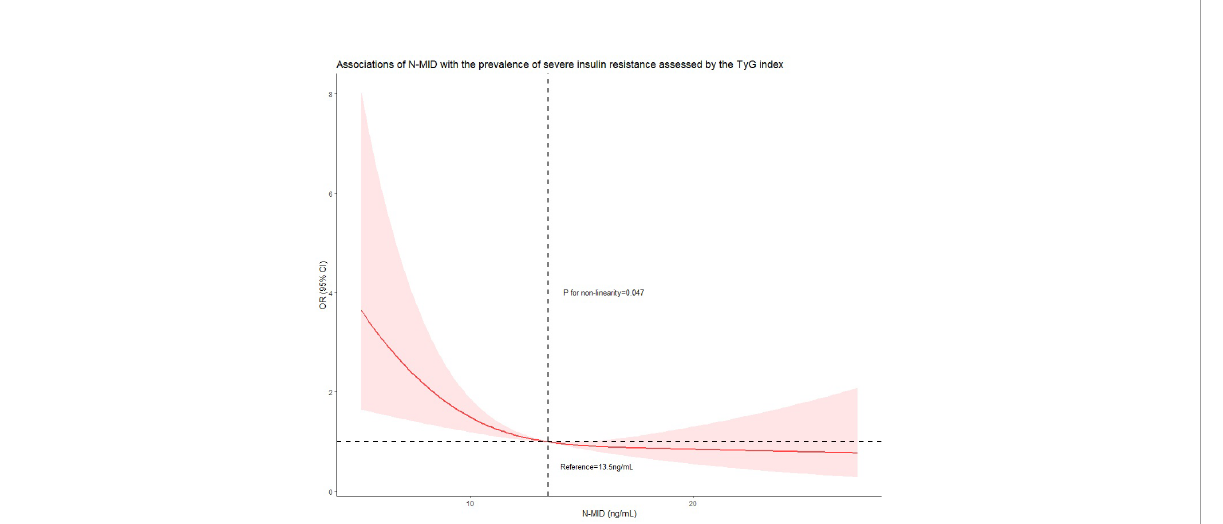
FIGURE 1 Restricted cubic spline curve was carried out with 3 knots at the 10th, 50th, and 90th percentiles of N-MID. When N-MID was approximately 13.5 ng/mL, as the reference, the estimated OR is equal to 1. The solid line represented point estimation on the association of N-MID (continuously measured) with the prevalence of severe insulin resistance assessed by the TyG index, and the shaded portion represented 95% CI estimation. Covariates in the model included age, BMI, diabetes duration, HbA1c, TC, hypertension, smoking status, the use of hypoglycemic agents and the use of lipid-lowering